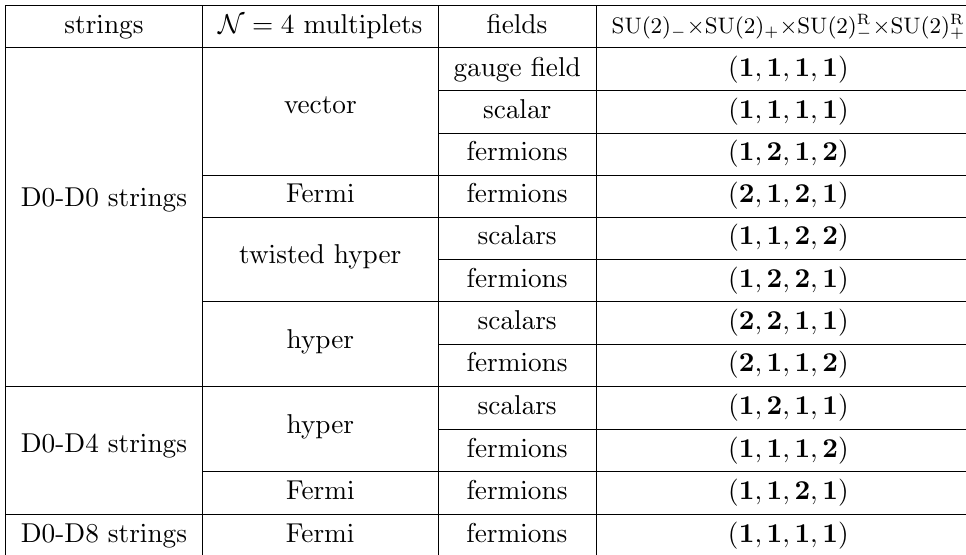
Table 11. The (cid:12)eld content of the D0-D4-D8/O8 quantum